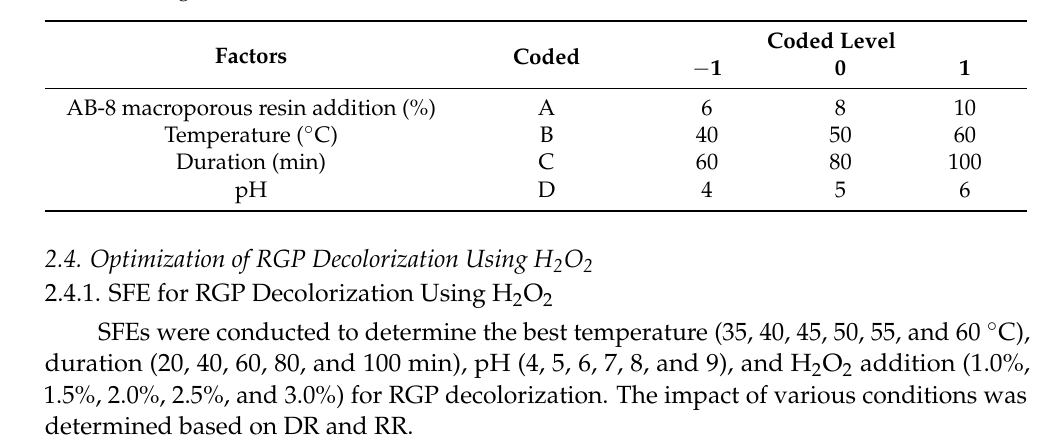
Table 1. Levels and codes of AB-8 macroporous resin decolorization variables used in the Box- Behnken design.